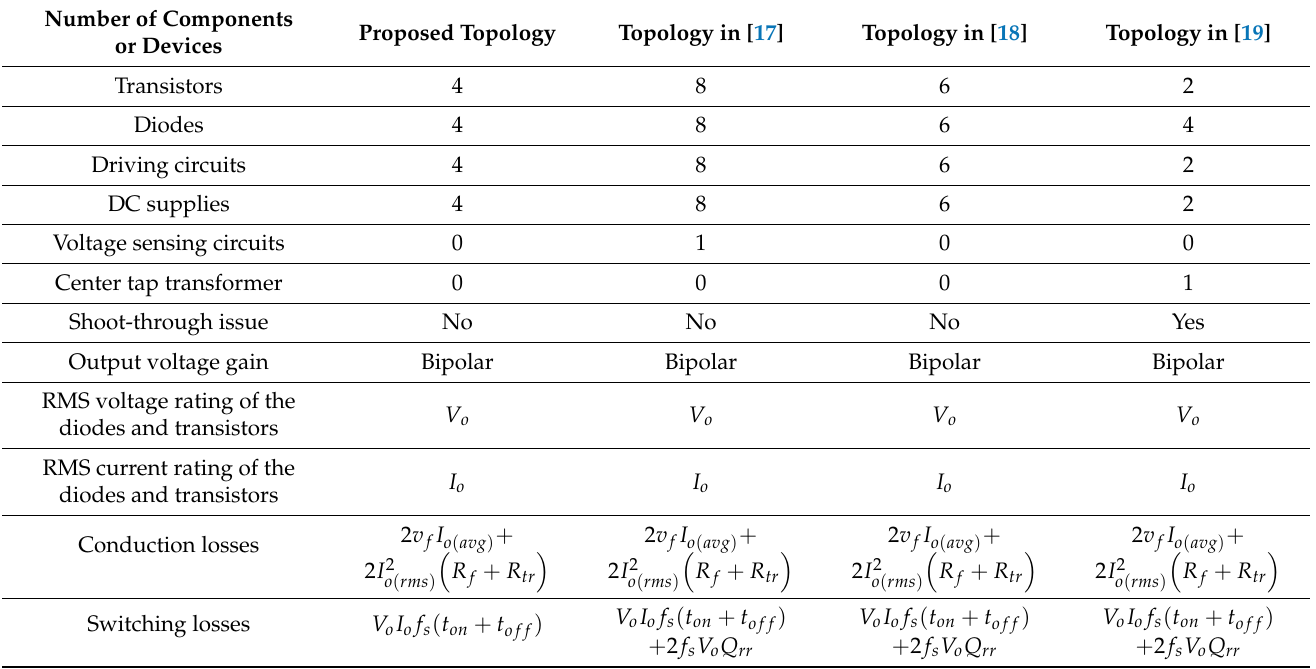
Table 2. Comparative analysis of the suggested and the recently-developed